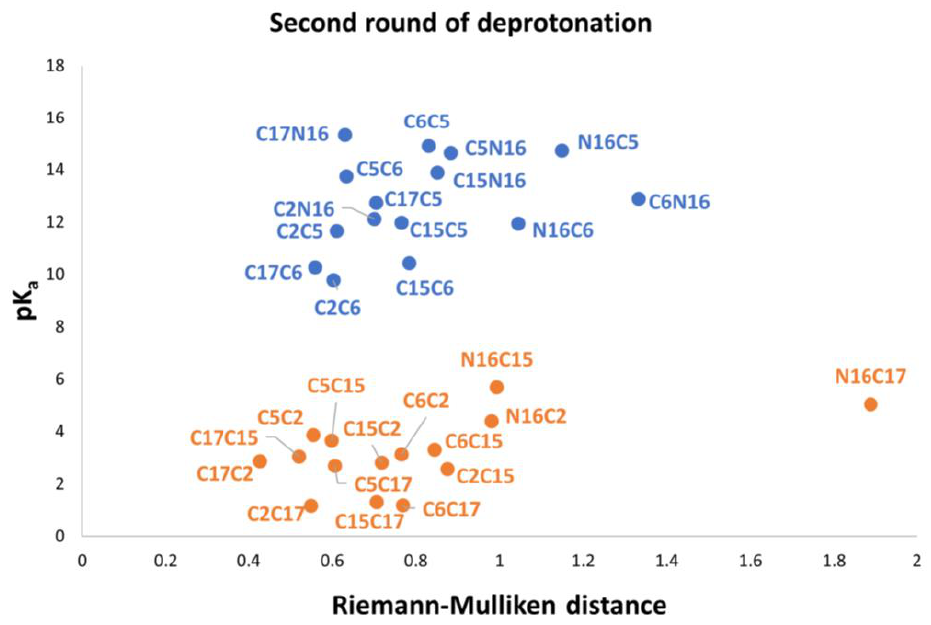
Figure 10. Relation between RMD and pK a values for all possible second deprotonations in Bd. The inferior cluster (orange) is strictly constituted by all the permutations of the low cluster in the first round (dihydropyridine ring nitrogen: C2, C15, C17). This cluster also involves all possible combinations of the superior group of the first round, catechol ring: C5, C6, and N16; followed by all possible combinations of the low cluster in the first round. The complementary set constitutes the superior cluster (blue). Note that the second deprotonation follows a rule that can be used for optimization of the computations. The superior cluster does not require computations because we already know that the pK a will be high. However, note that the inferior cluster must be computed completely because the addressed rule cannot provide the best route.